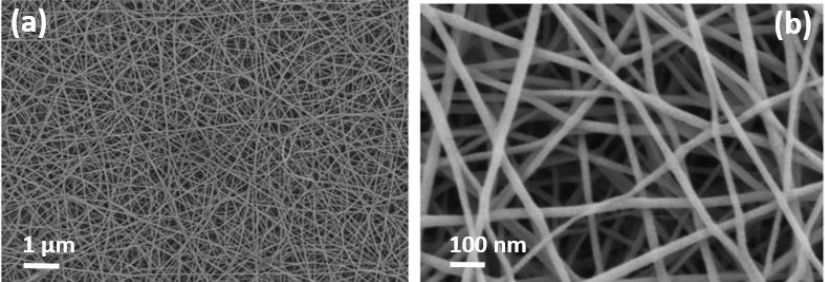
Figure 1. FESEM images of a typical nanofibers (NFs) layer used in this study. Two different magnifications have been used: (a) 10K (scale bar 1 µm); and (b) 100K (scale bar 100 nm).